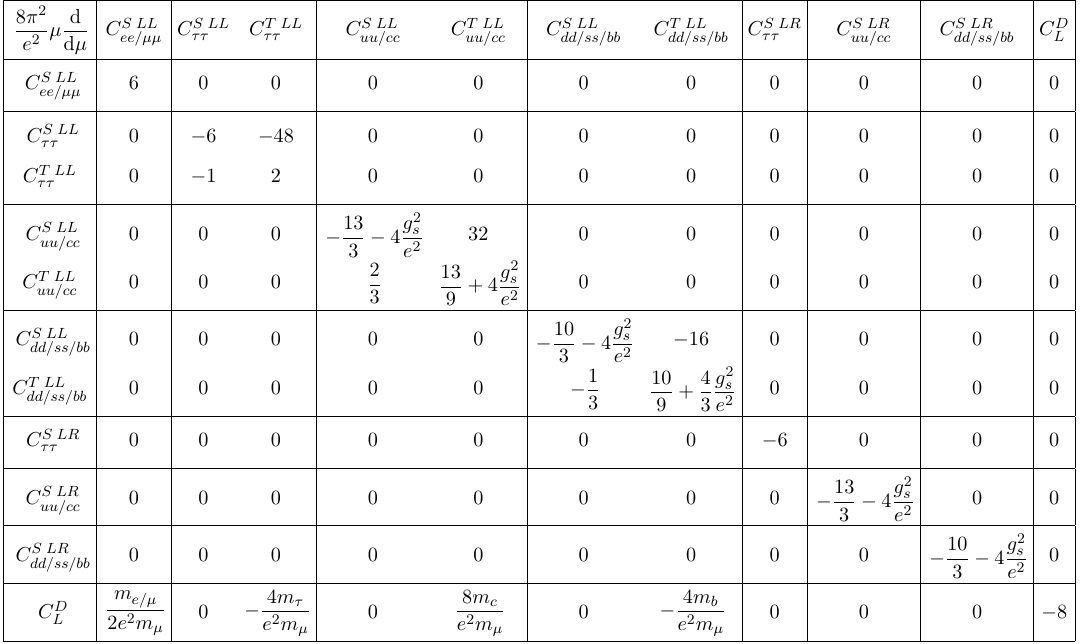
Table 1. Entries of the transposed anomalous dimension matrix (cid:0) ST for the scalar-tensor sector.